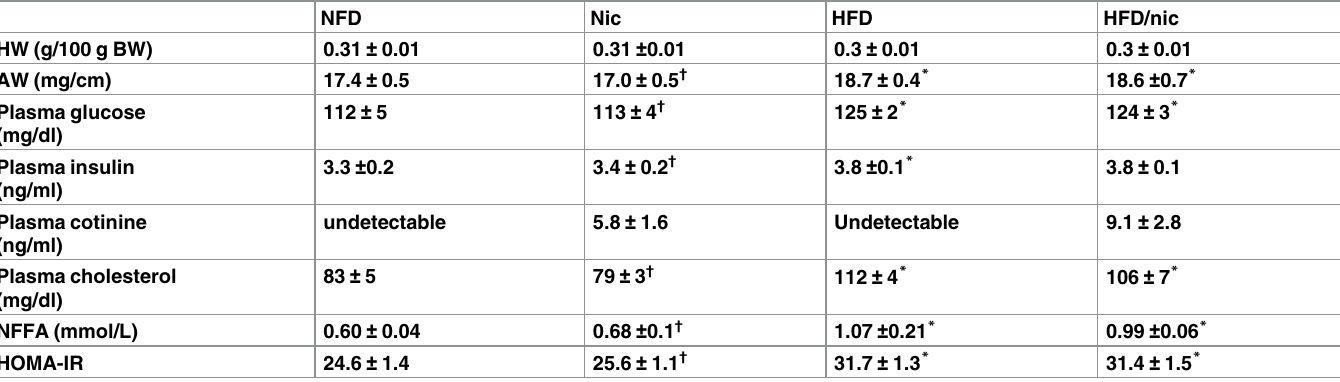
Table 1. Effects of nicotine and obesity on metabolic